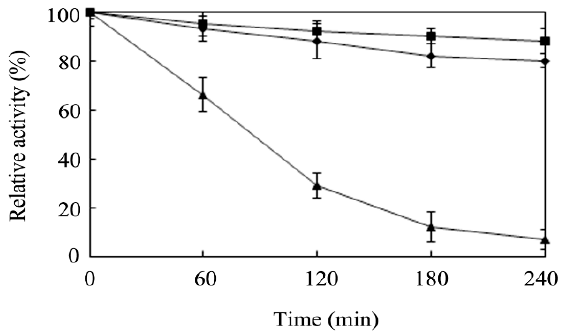
Figure 4. Thermostability of r ‐ Ao FT. The residual enzyme activity was measured after incubation of the purified enzyme at 50 °C ( boxes ), 55 °C ( diamonds ), and 60 °C ( triangles ), respectively. The values are means of three independent experiments.